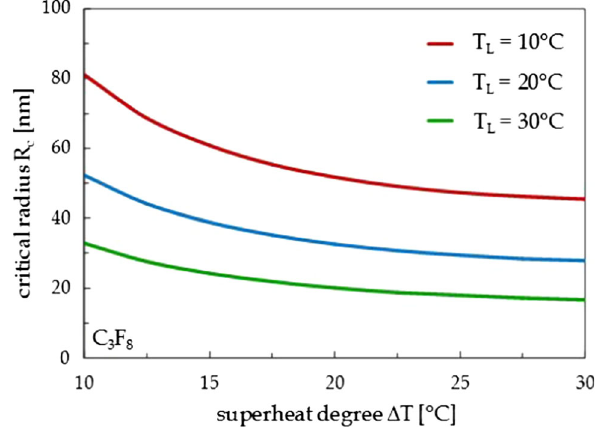
Fig. 4 Distributions of R c vs. (cid:4) T for C 3 F 8 using T L as a parameter